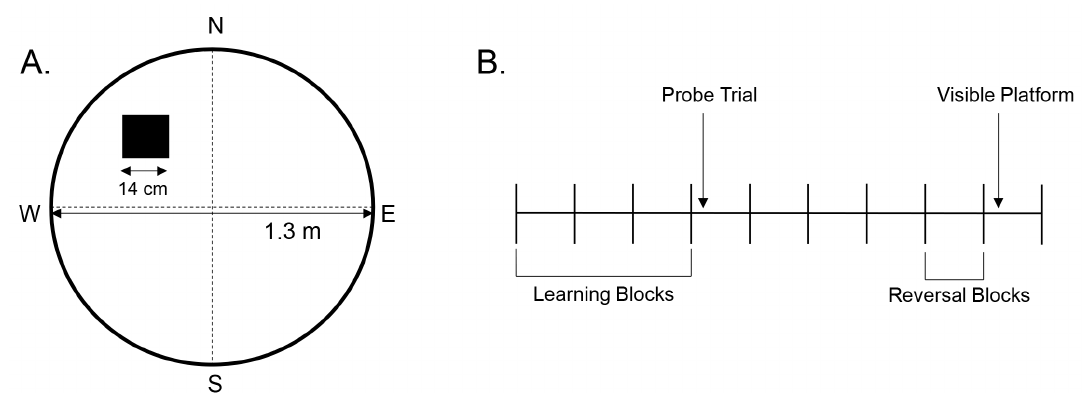
Figure 1. Overview of the testing paradigm. A . An overview of the set-up of the testing arena. B . An overview of the progression of testing